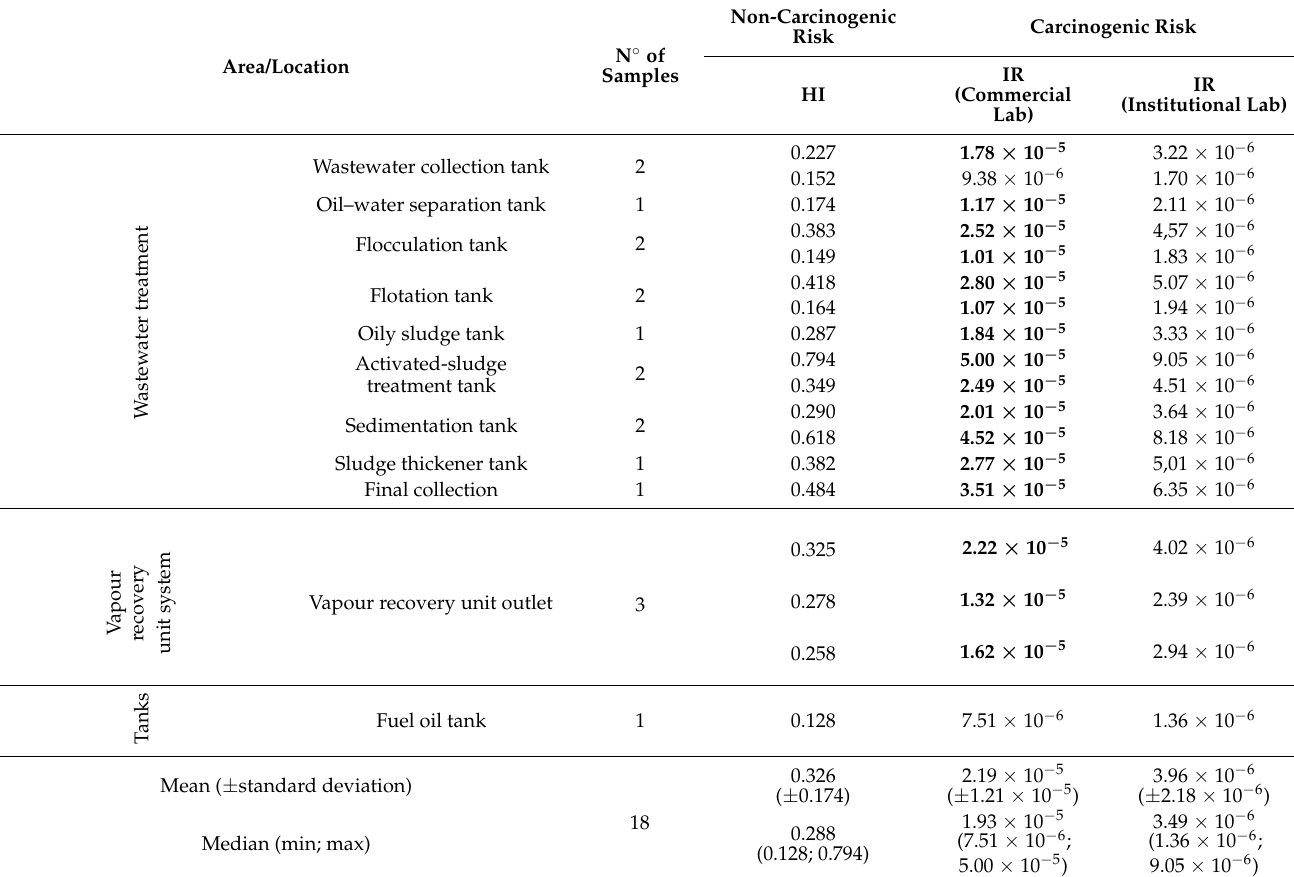
Table 2. Risk assessment evaluation for refineries samples. HI = hazard index; IR = inhalation risk.